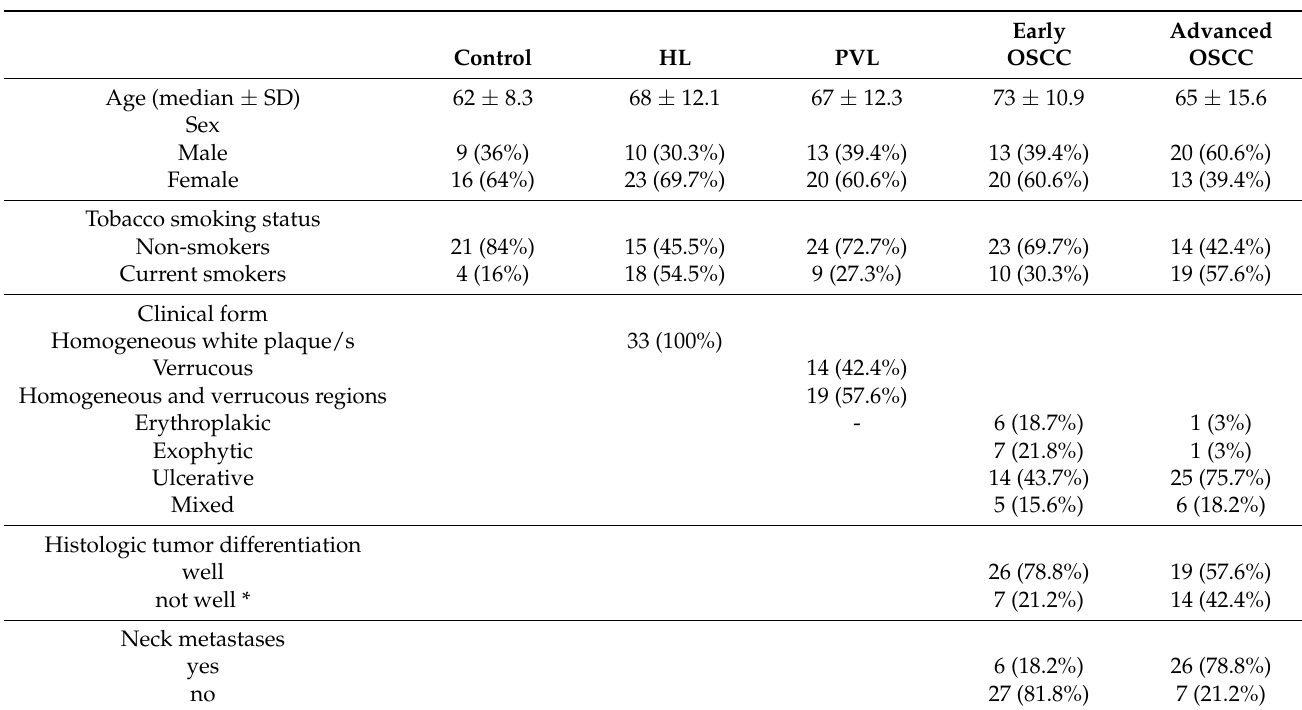
Table 1. Demographic characteristics of control subjects ( n = 25), homogeneous leukoplakia (HL) ( n = 33), proliferative verrucous leukoplakia (PVL) ( n = 33) and oral squamous cell carcinoma (OSCC) patients at early ( n = 33) and advanced ( n = 33)